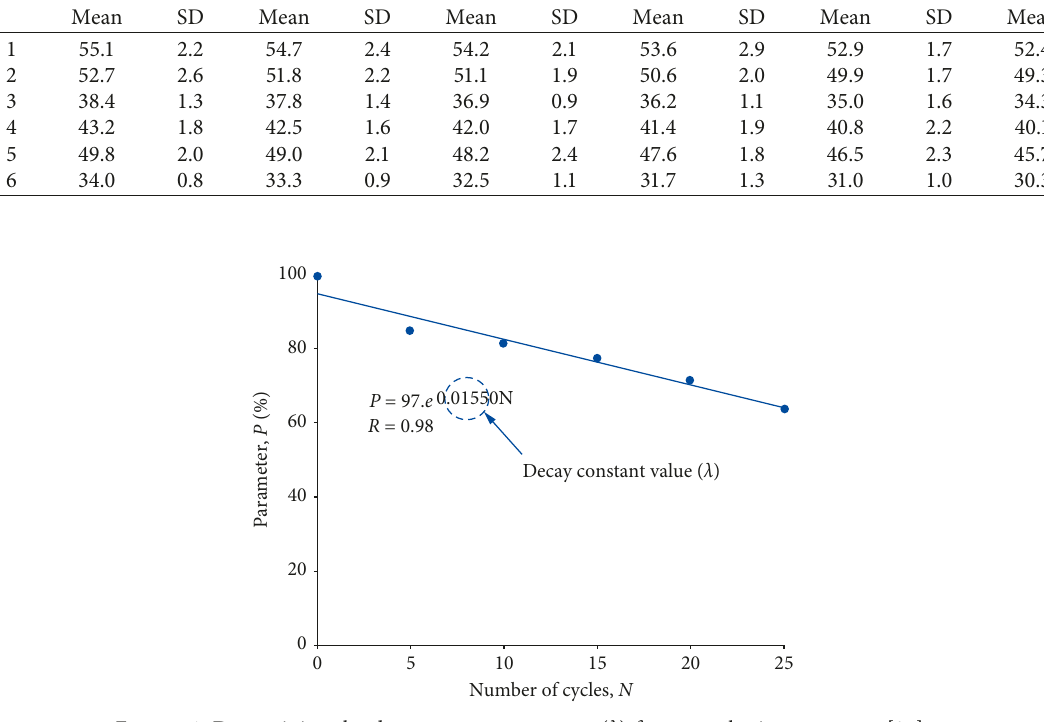
Table 4: Mean and standard deviation (SD) of Schmidt hammer rebound (Sch) values before and after frost cycles. Cycles